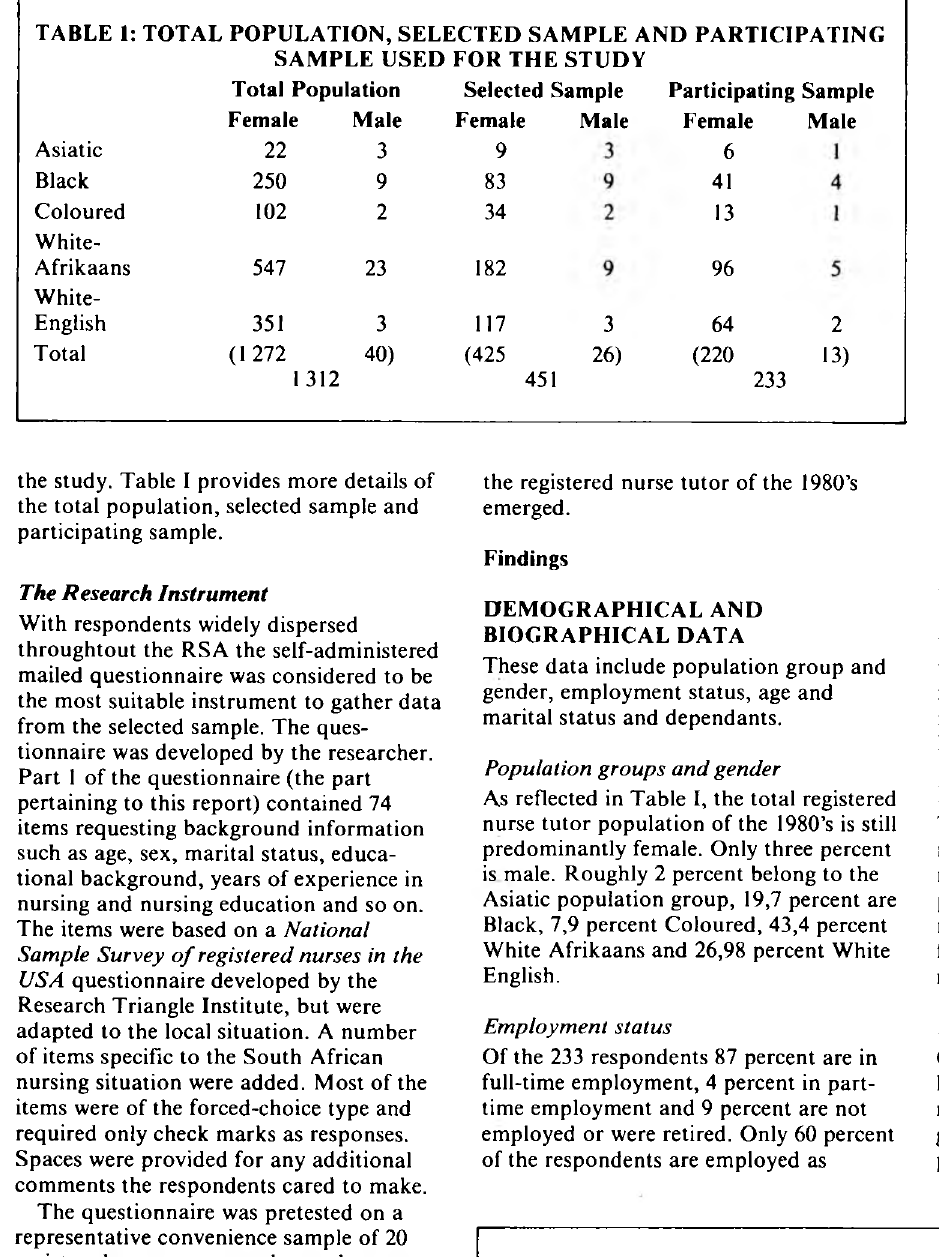
TABLE 2: AGE DISTRIBUTION OF REGISTERED NURSE TUTORS